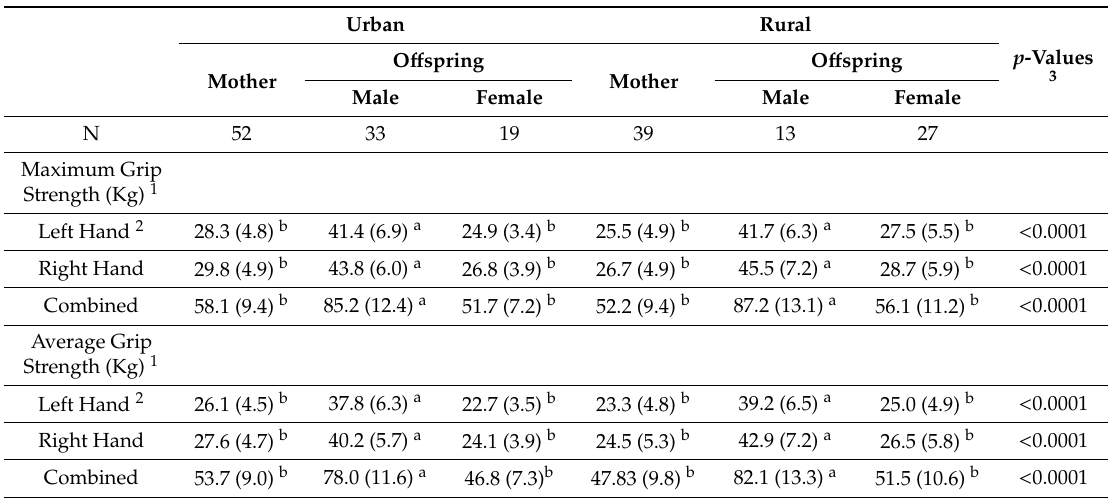
Table 2. Grip strength of Chinese mothers and o ff spring measured with the Takei Digital Grip Strength Dynamometer, Model T.K.K.5401.